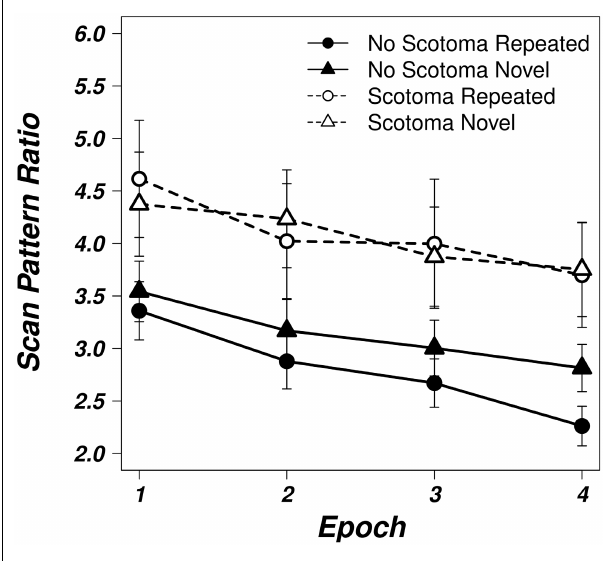
epoch [ F (1,24) = 30.156, p < 0.05], a significant main